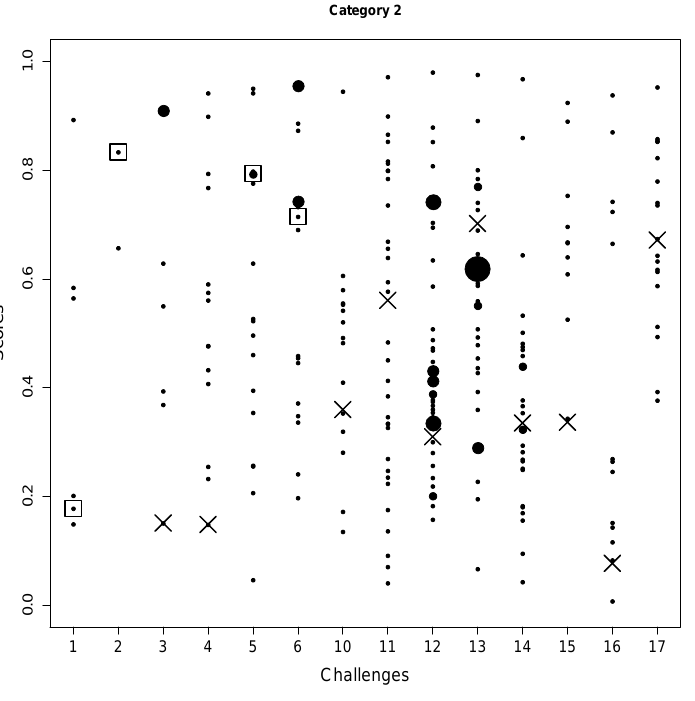
Figure 3. The scores of all candidates (y-axis) for the challenges (x-axis) are shown in black dots where the size indicates the number of candidates sharing the same scores. The correct solutions are indicated with a square. For the challenges where the correct molecules were not in the database, the hypothetical rankings (assuming the molecules were in the database) of the true molecules are shown by the cross